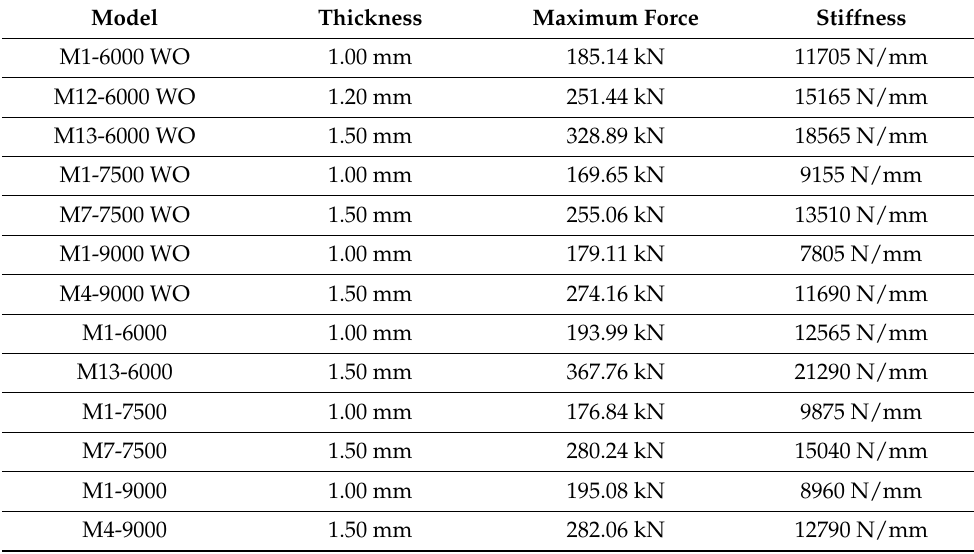
Table 5. Influence of corrugated web